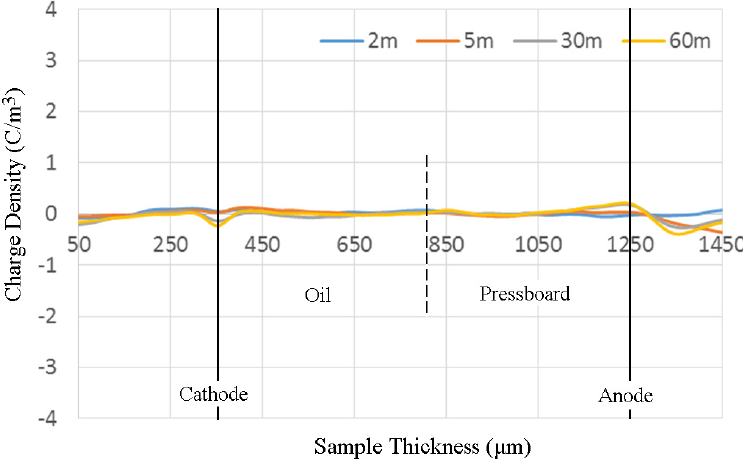
Figure 27. Volt ‐ off results of space charge in fresh oil combined with impregnated pressboard insulation system under 4.8 kV/mm DC field.